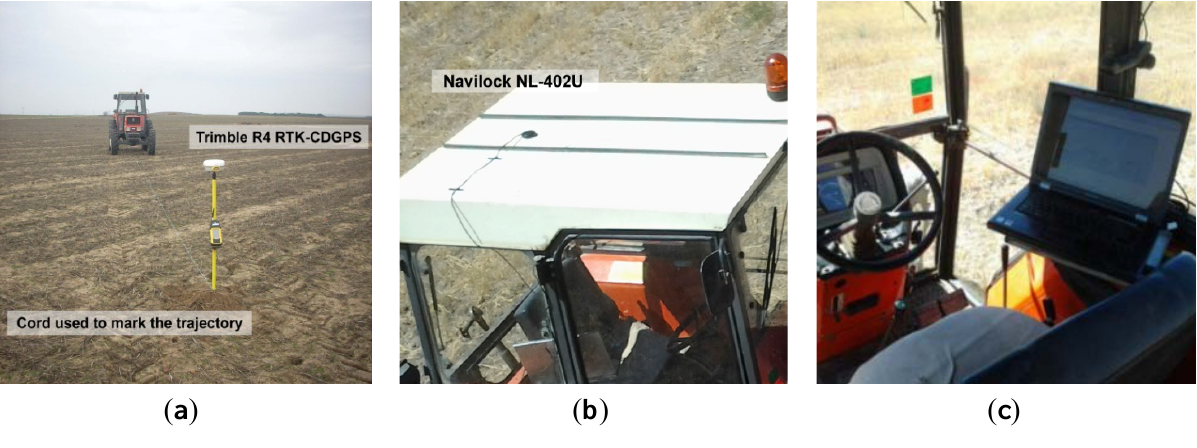
Figure 9. ( a ) One of the trajectories of the tests with one stake and the cord; ( b ) Low-cost GPS receiver placed over the tractor cab; ( c ) Laptop inside the tractor